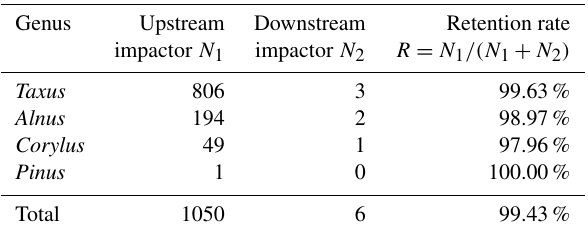
Table 2. Number of pollen grains collected in impactor 1 and im- pactor 2 of the arrangement of Fig. 7 for determination of the reten- tion rate and thus the extraction efficiency of the newly developed impactor.